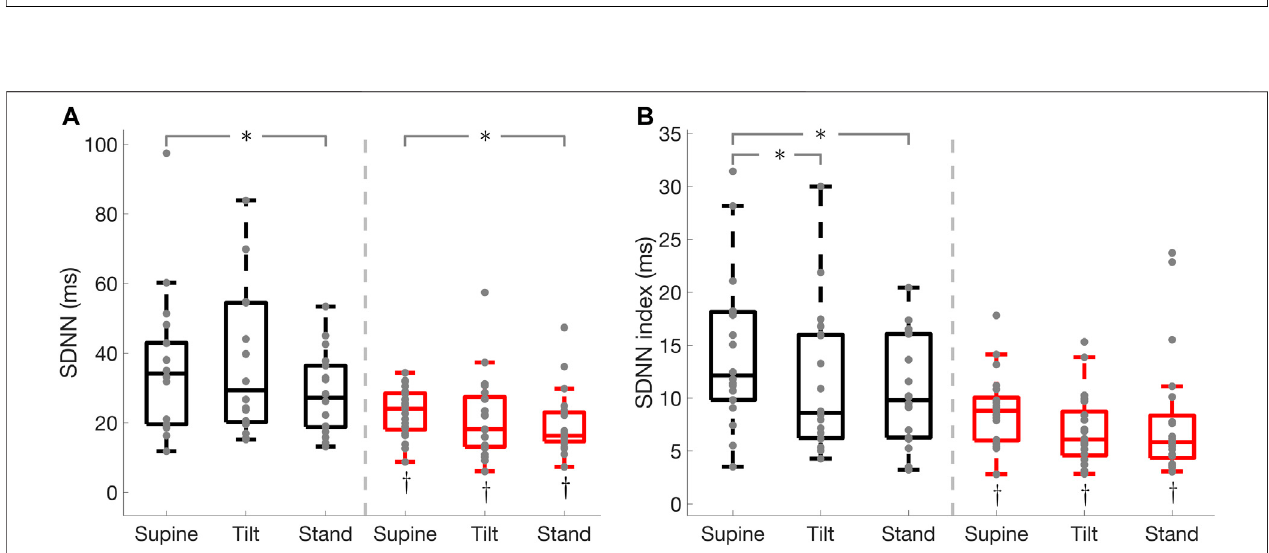
FIGURE5| StandarddeviationofnormalRRinterval(SDNN),andSDNNindexinParkinson ’ sdiseaseandhealthycontrols.SDNN (A) ,SDNNindex (B) .*illustrates a signi fi cance difference for multiple comparison (post-hoc analysis with Bonferroni adjustment) between supine, tilt, and standing in Parkinson ’ s disease patients (red) and healthy controls (black), while † represents a signi fi cant difference (Wilcoxon rank sum test) between Parkinson ’ s disease patients and healthy controls.